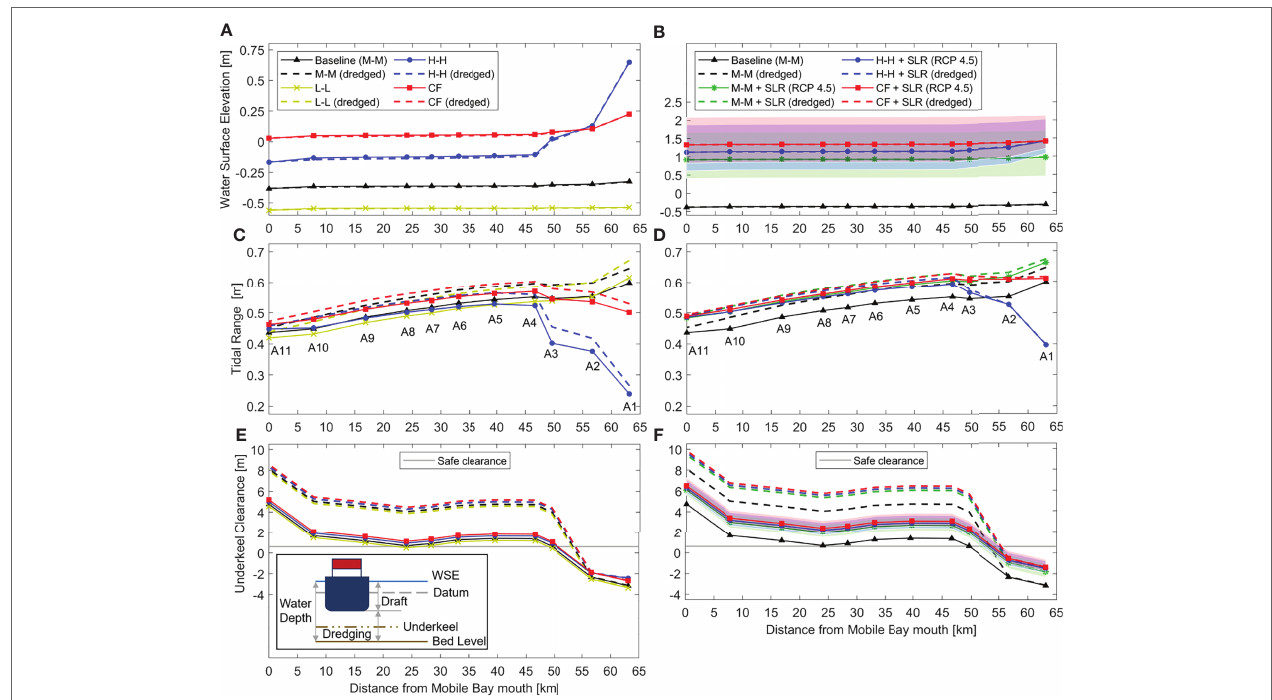
FIGURE 4 | Profiles along control stations (A1 to A11) in the Mobile Bay channel with current bathymetry (solid line) and after channel dredging (dashed line). The scenarios consider mean river flow (RF) and mean sea level (M-M scenario), low RF and mean lower low water (L-L), high RF and mean higher high water (H-H), and Compound flood (50-year return period) under current mean sea level (left panel) and sea level rise projections at Dauphin Island (right panel). Profiles show (A, B) mean water surface elevation (WSE), (C, D) mean tide range, and (E, F) underkeel clearance (U) for safe navigation where the gray horizontal line represents a threshold-value that prevents any potential damages to vessels. Shaded bands indicate WSEs and U-values between 5 th and 95 th percentiles. Left bottom corner shows a schematic of a draft-vessel and the associated clearance. Mobile Harbor is located at control station